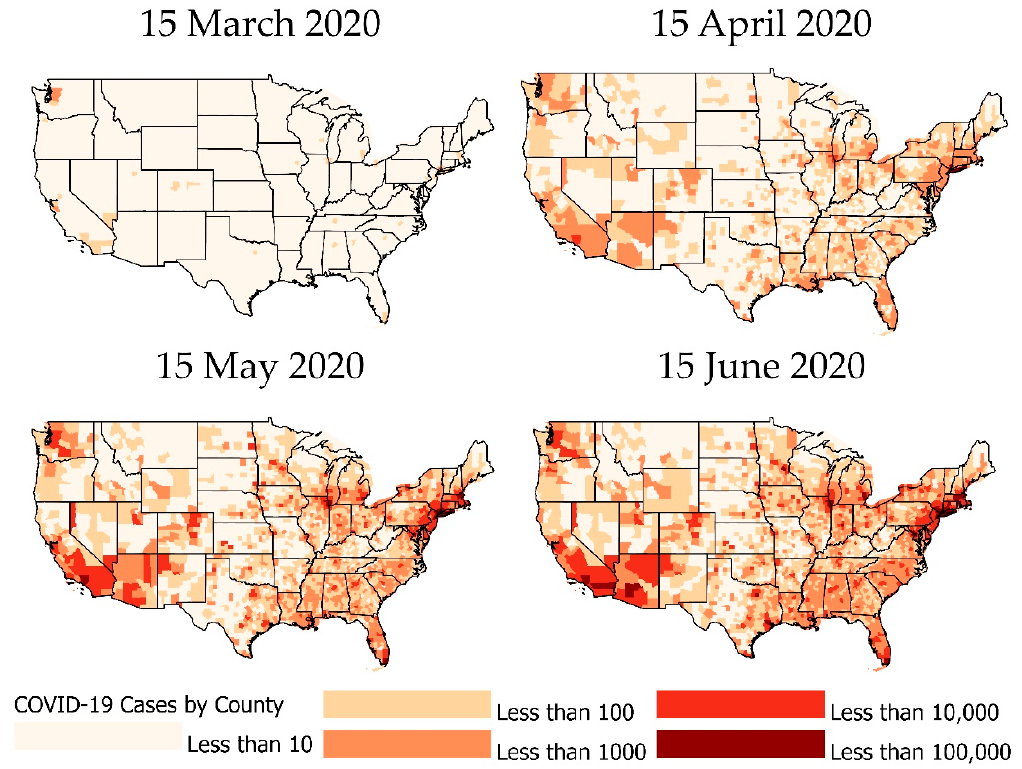
Figure 2. The number of cumulative COVID-19 cases per county from 15 March to 15 June 2020.